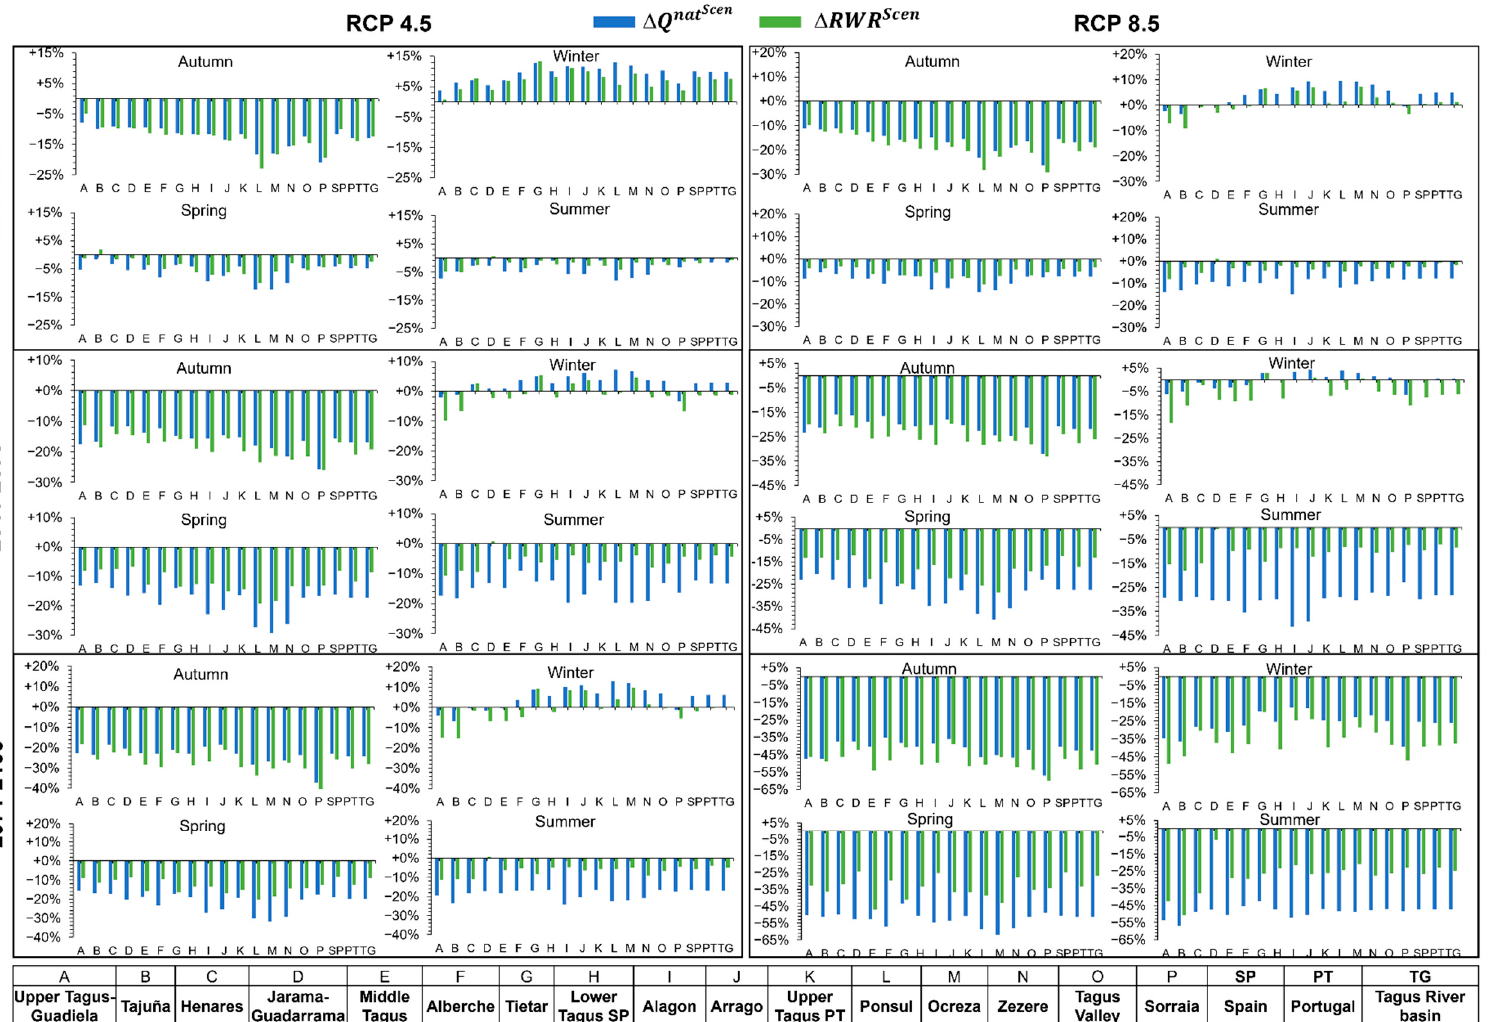
Figure 3. The comparison of ∆𝑅𝑊𝑅 (cid:3036),(cid:3047) (green bars) and ∆𝑄 (cid:3036),(cid:3047)(cid:3041)(cid:3028)(cid:3047) (blue bars) for three future horizons under RCP 4.5 and RCP 8.5.